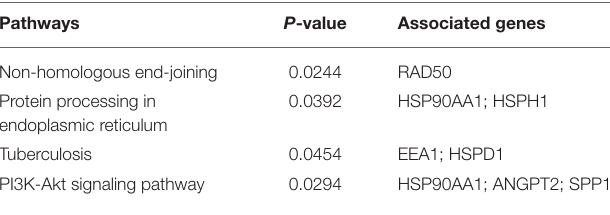
TABLE 2 | The enriched molecular pathways of differentially expressed genes (DEGS) in PAH disease. Pathways P -value